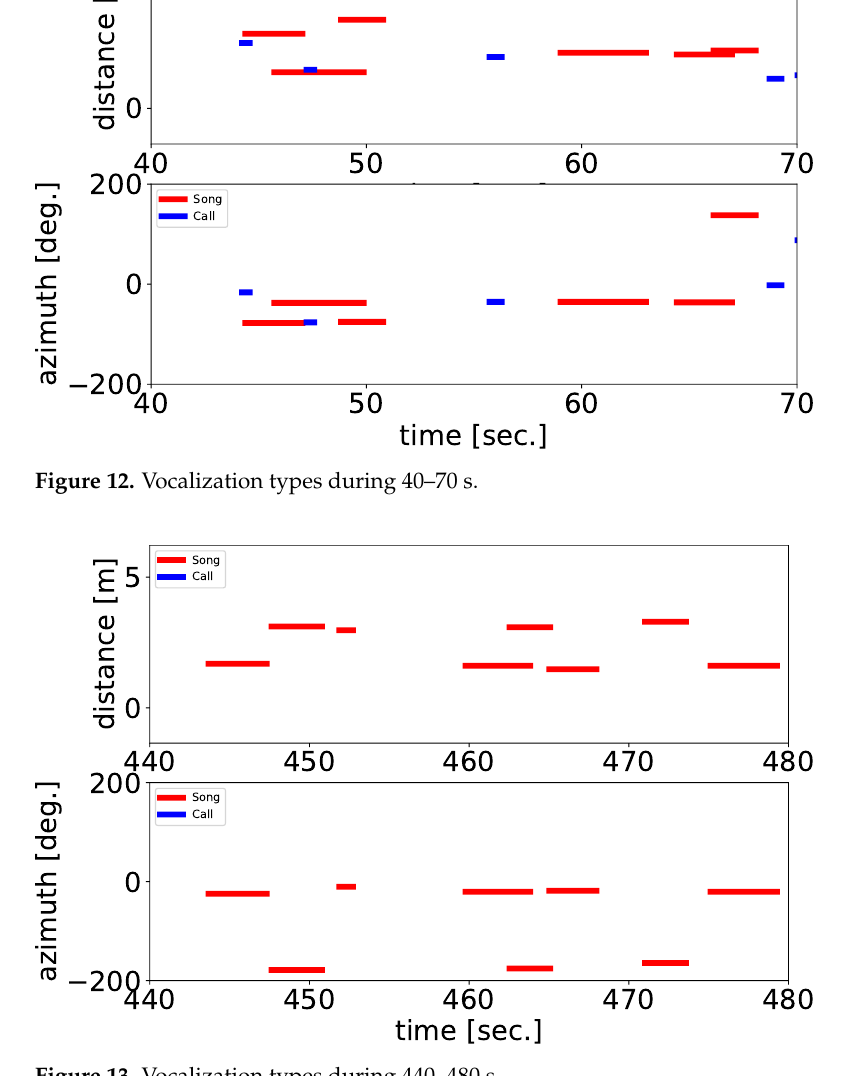
Figure 13. Vocalization types during 440–480